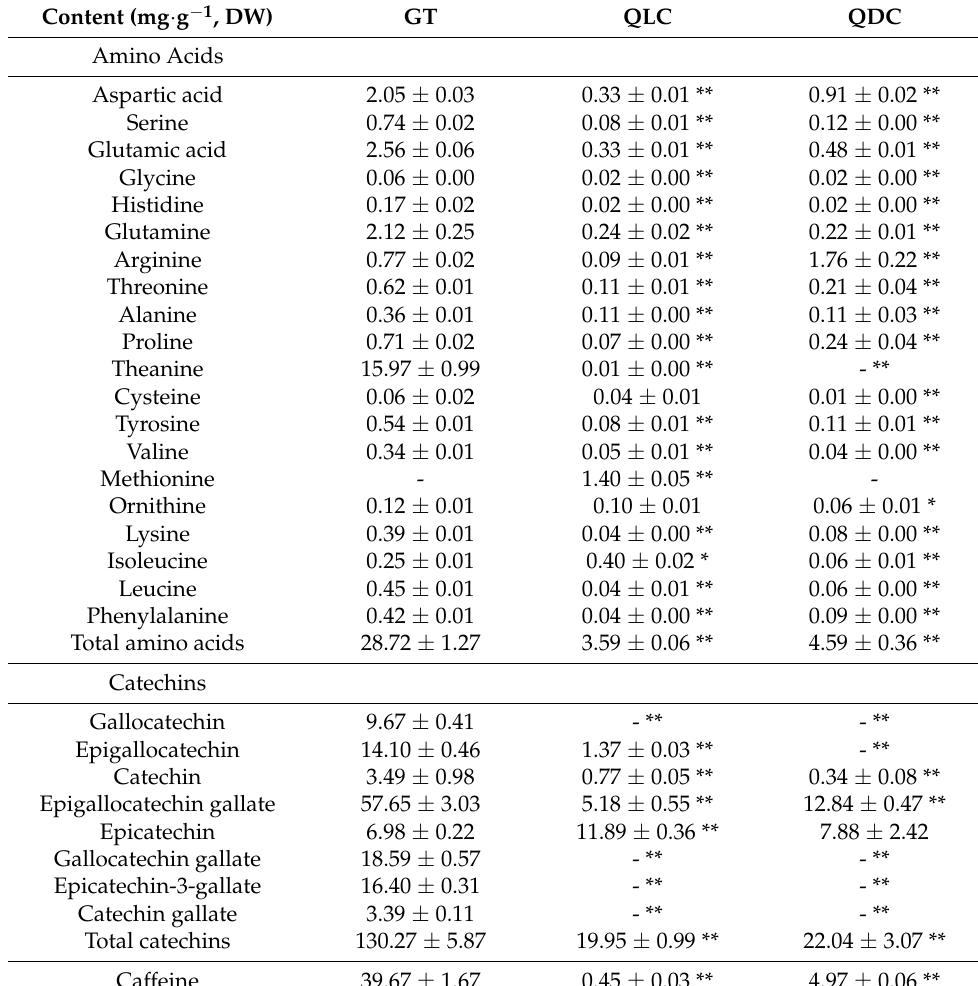
Table 1. Contents of amino acids, catechins, and caffeine in three tea